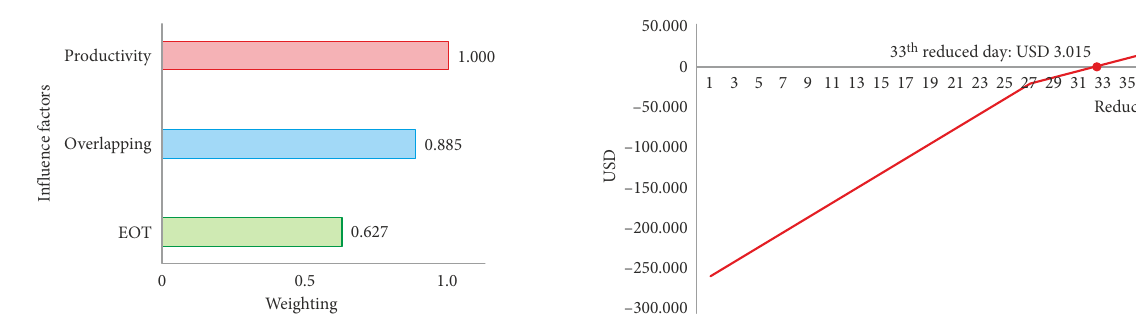
according to duration